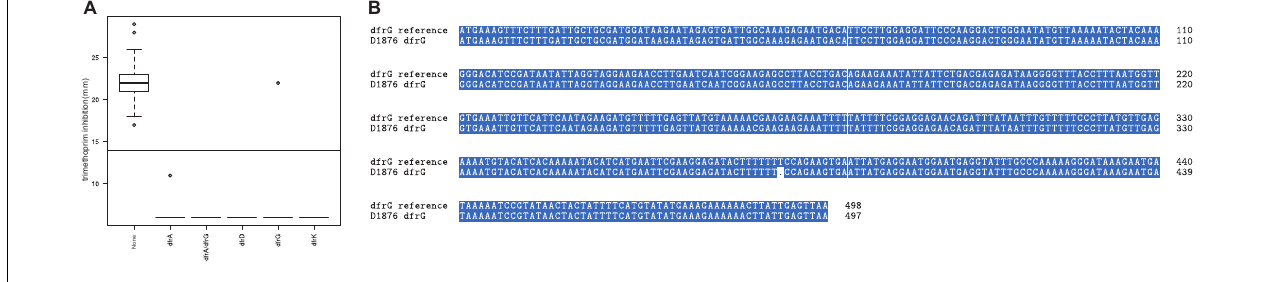
FIGURE 1 | Extra chromosomal DHFR predicted trimethoprim resistance. (A) zone of inhibition of trimethoprim (in mm) grouped by the DHFR variants. One isolate (D1876) carrying dfrG exhibited a susceptible phenotype. (B) Nucleotide sequence of the dfrG in D1876 showed a thymine deletion at position 381 compared to the reference dfrG